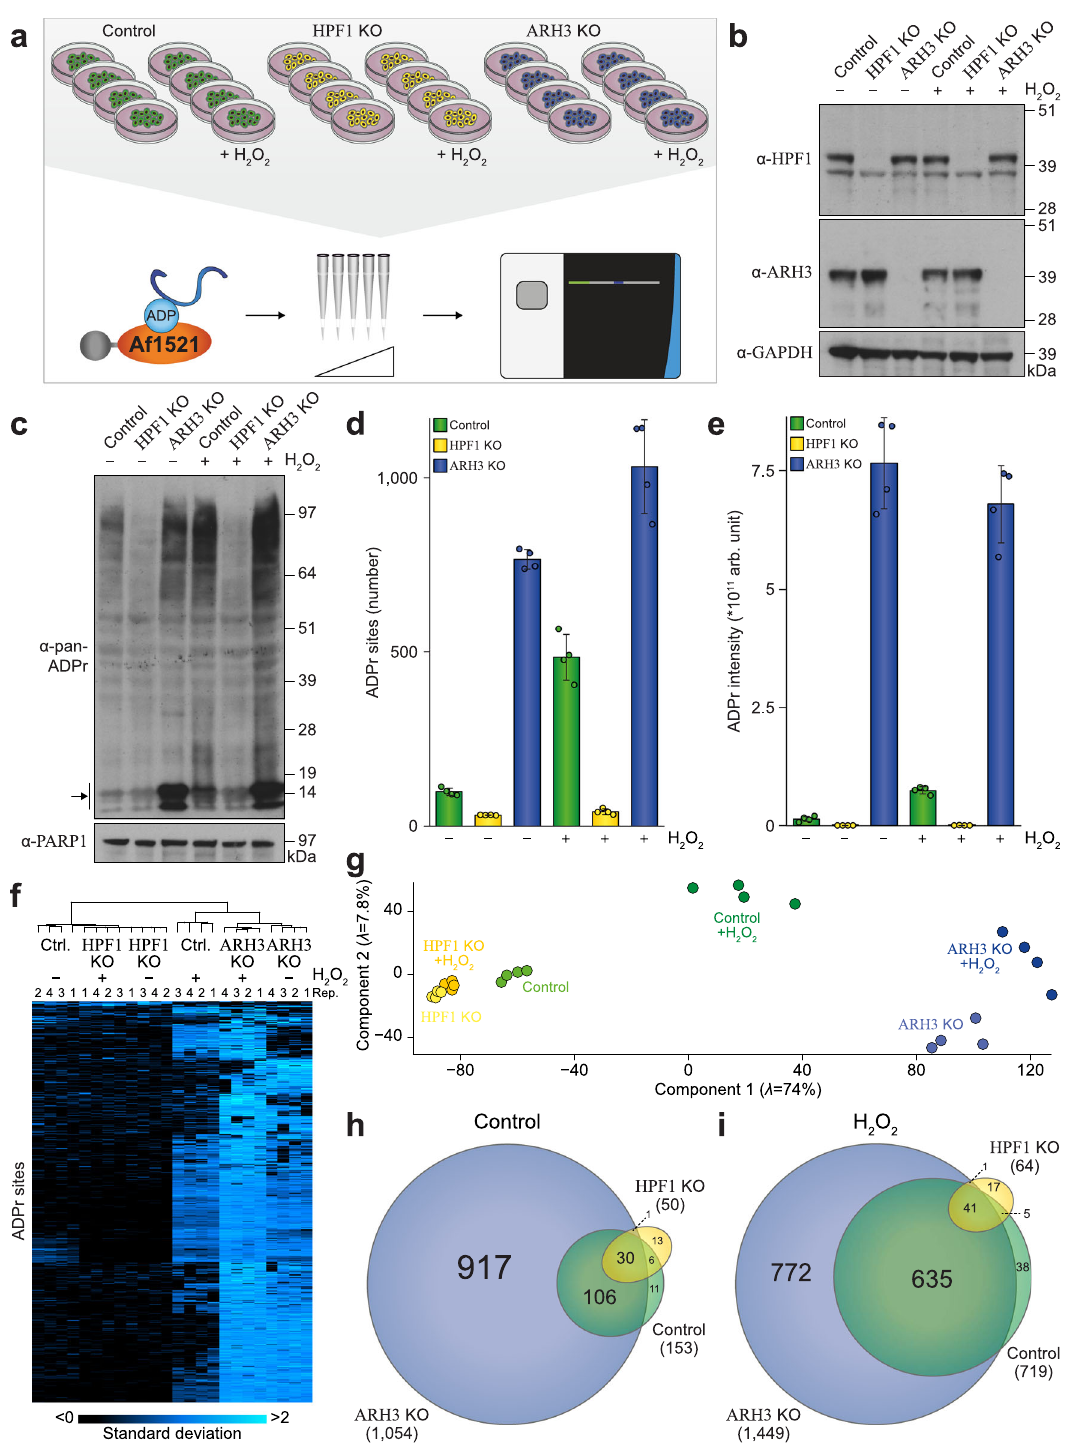
Fig. 4 The ADP-ribosylome in HPF1 and ARH3 knockout cells. a Overview of the experimental design. U2OS cells, either wild-type (control), HPF1 knockout (KO), or ARH3 KO, were cultured in quadruplicate ( n = 4), and either mock- or H 2 O 2 -treated at 1mM for 10min. ADPr sites were enriched using the Af1521 methodology, fractionated, and analyzed using high-resolution MS. n = 4 cell culture replicates. b Immunoblot analysis validating the knockout of HPF1 and ARH3. This experiment was performed as two independent biological replicates, with similar results. The same set of samples was loaded on multiple membranes as technical replicates, to allow readout using different antibodies. Ponceau-S loading controls for each membrane are available in the Source Data. c As b , but highlighting the ADPr equilibrium in control, HPF1 KO, and ARH3 KO cells, ± H 2 O 2 treatment at 1mM for 10min. The arrow indicates histone ADPr. d Overview of the number of identi fi ed and localized ADPr sites. n = 4 cell culture replicates, data are presented as mean values±SD. e As d , showing ADPr abundance. f Hierarchical clustering analysis of z -scored ADPr site abundances, visualizing the relative presence of ADPr sites across the experimental conditions. g Principle component analysis indicating the highest degree of variance between sample conditions. h Scaled Venn diagram depicting the overlap between ADPr sites in untreated cells. i As h , but for H 2 O 2 -treated cells. Source data are provided as a Source Data fi le.